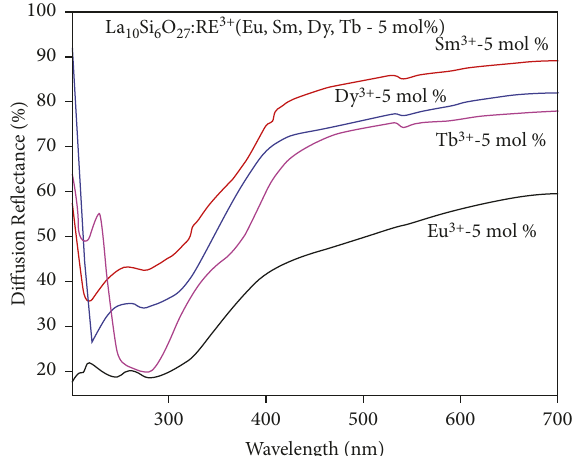
Figure 6: Energy band gap spectra of La and Tb -5 mol %)